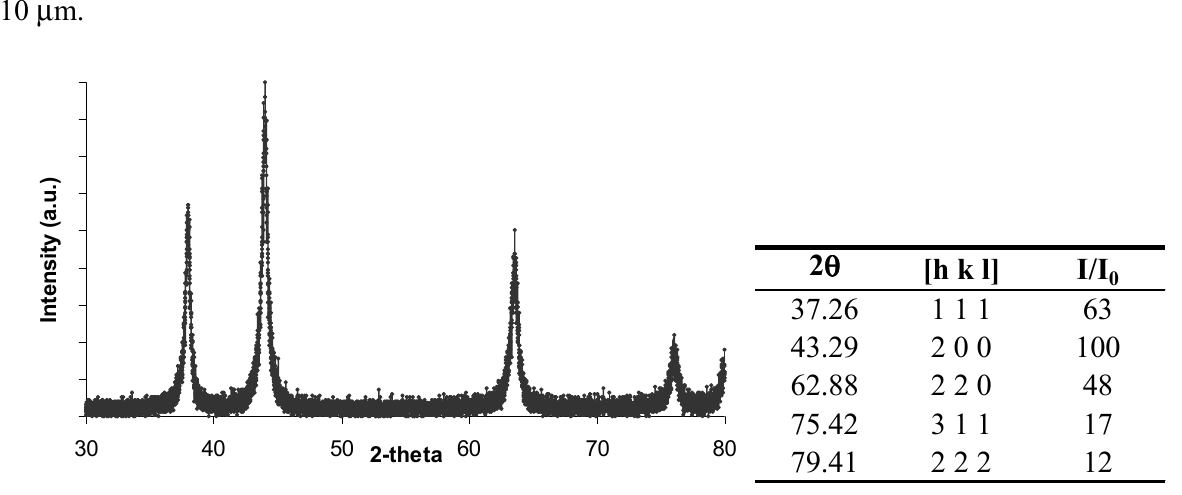
Figure 1. XRD patterns of screen-printed NiO thick film and standard XRD peaks for NiO.